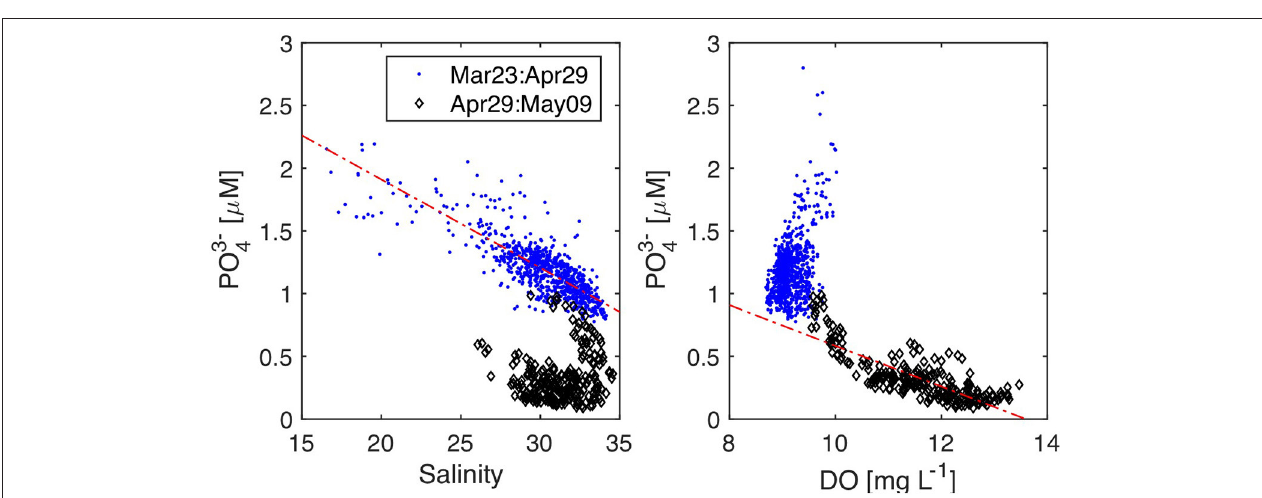
FIGURE 10 | Property-property plots for Southampton Water deployment. (A) Phosphate vs. YSI Salinity y = − 0.07 ± 0.002 * x + 3.3 ± 0.06 R 2 = 0.63 (Mar 23–Apr 29, n = 856), (B) Phosphate vs. YSI Dissolved Oxygen y = − 0.16 * x + 2.2 R 2 = 0.65 (Apr 29–May 09).